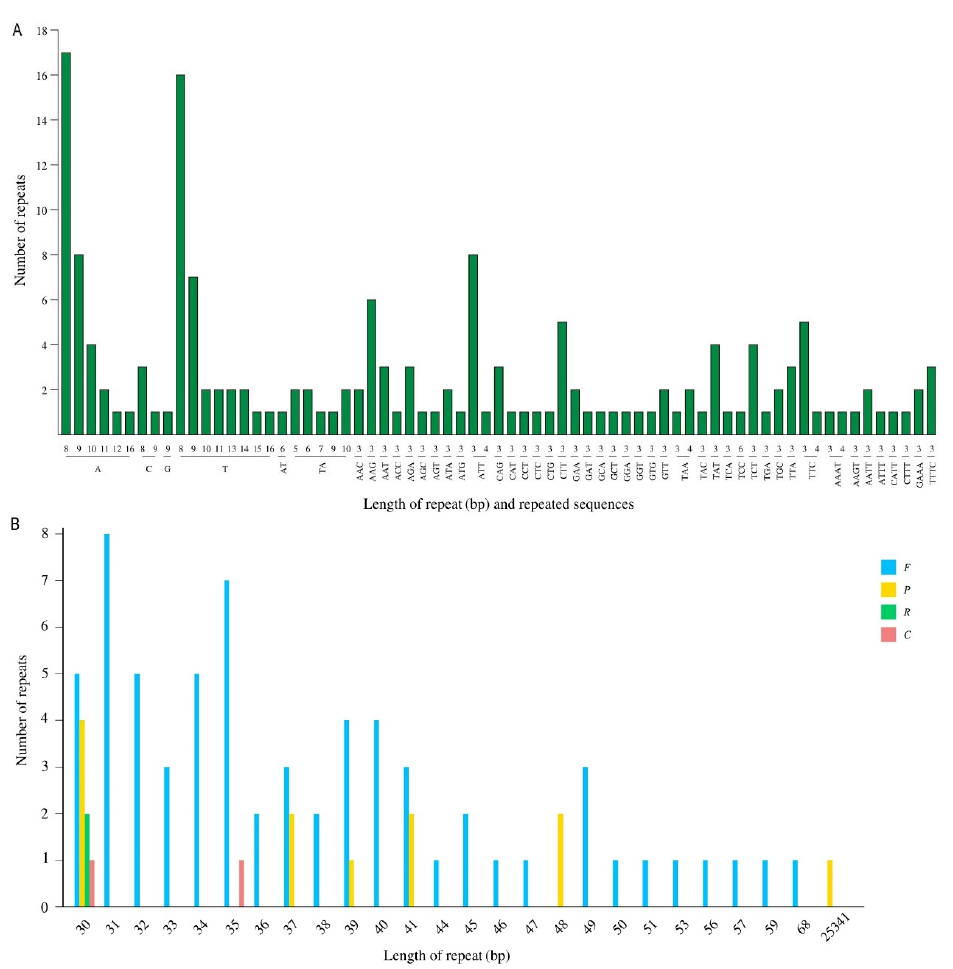
Figure 4. Analysis of repeat sequences in chloroplast genome of ‘Mahu Chuncai’. ( A ) Number and distribution of SSRs. The X ‐ axis represents length of repeat and shows the repeated sequences or repeat unit, while the Y ‐ axis represents numbers of SSRs of each type. Four colors of rectangle boxes on behalf of four types of repeated sequences, brown for mononucleotide repeats, blue for dinucleotides repeats, red for trinucleotides repeats, purple for tetranucleotides repeats. ( B ) Number and distribution of IRSs. Length represents the length of the repeat sequence. Type represents the type of repeat sequence. The number of each type represents the number of each type. The X ‐ axis shows the types of dispersed repeats, while the Y ‐ axis shows the number of dispersed repeats. F: forward repeat, P: palindrome repeat, R: reverse repeat, C: complementary repeat.